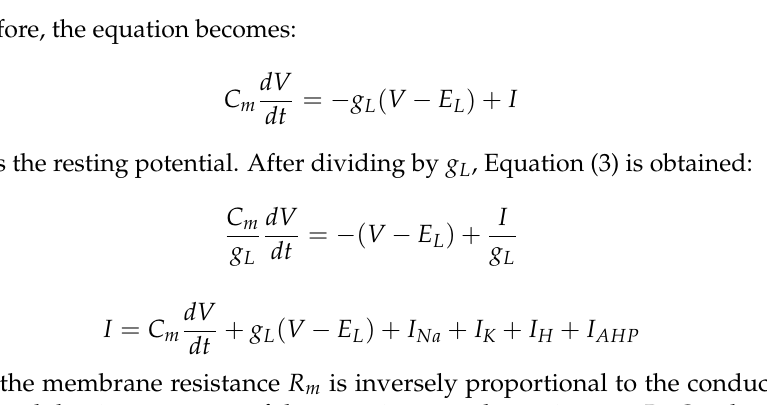
Figure 1. Hodgkin–Huxley model describes the exchange of ionic species across the extracellular and intracellular space separated by a biological membrane. C m refers to the membrane capacitance, t is time, V m is the membrane voltage, V L is leakage voltage, and I p is the ionic current through the ion pumps. Figure inspired from [1].